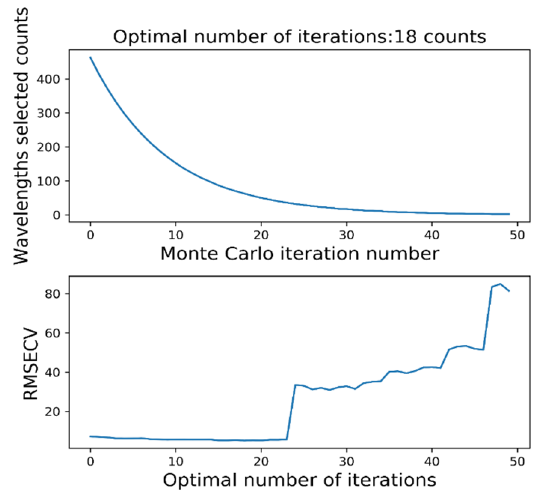
Figure 9. CARS algorithm’s feature band selection.